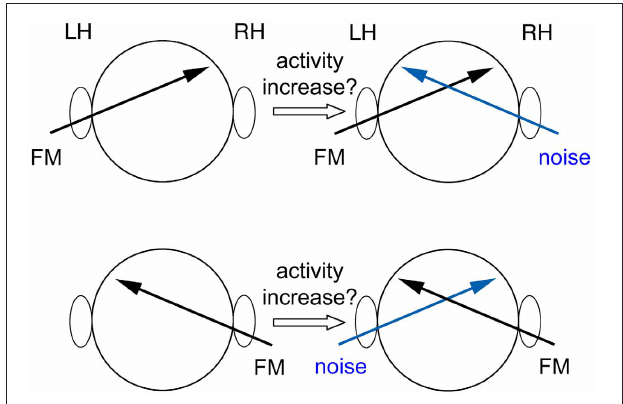
FIGURE 1 | Sketch of the experimental conditions. The FM tones were presented either binaurally (not shown), monaurally to the right or left ear with or without contralateral white noise. Activity was compared between conditions without noise and conditions with noise. The location of the activity increase due to additional noise reveals the location of processing of the task at hand. (LH, left hemisphere; RH, right